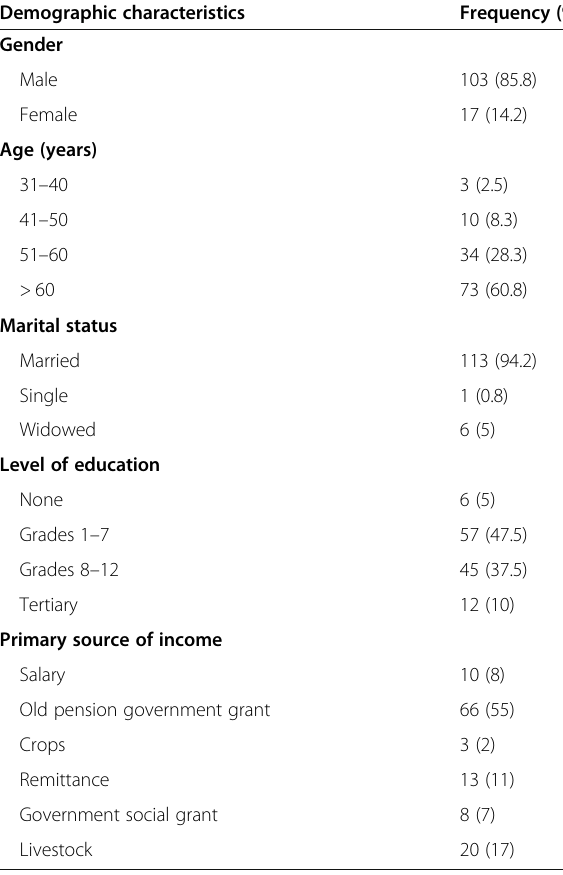
Table 2 Demographic characteristics of the Nguni Cattle Project beneficiaries (No. = 120)